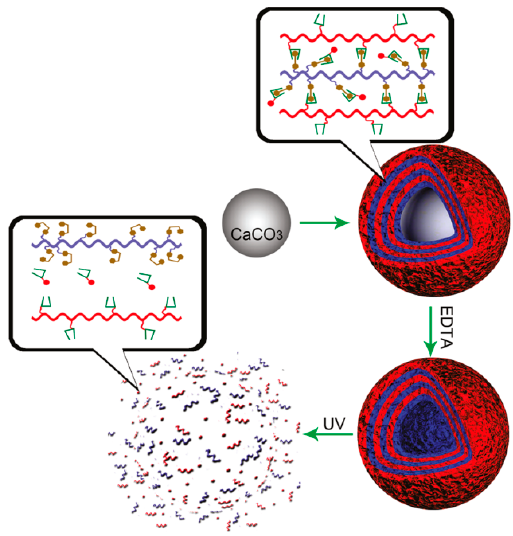
Figure 12. Photo-induced burst release of rhodamine B-labeled α -cyclodextrin ( α -CD-RhB) from a